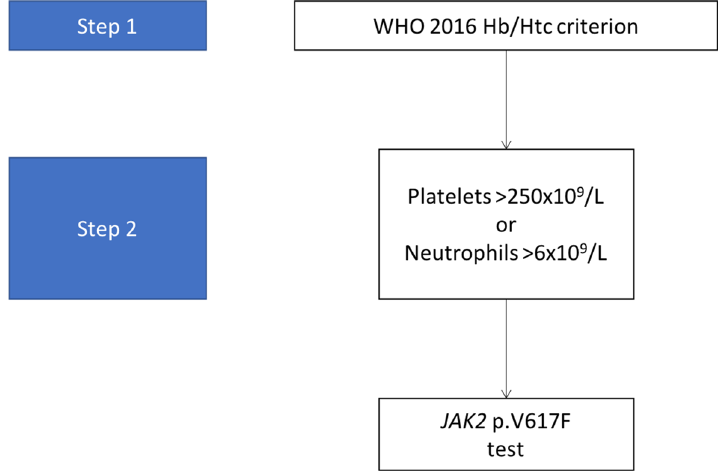
Figure 4. Simplified two-step algorithm. This figure shows a simplified version with rounded threshold